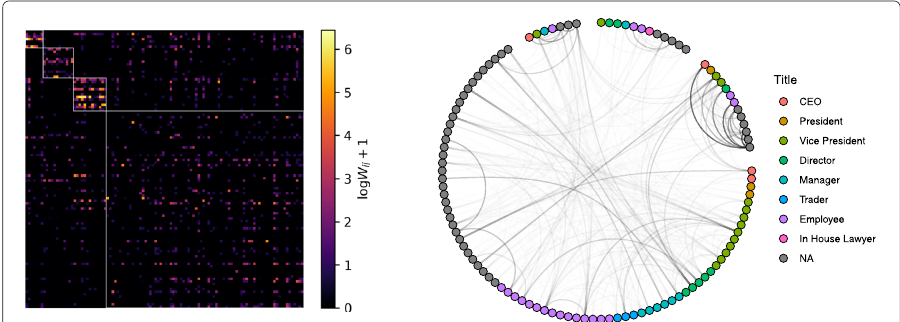
Fig. 4 Example partition of the Enron data set via approximate spectral maximization of Eq. (9). (Left): The adjacency matrix, arranged in order of the partition. Colors give the value of log W ij + 1; log-scaling was chosen for readability. (Right): Visualization of the network. Directed edges have been made undirected. The darkness of each edge corresponds to its weight. The color of each node corresponds to listed job title. In this experiment, k = 4, and the kernel used is the information flow kernel R of Eq. (10). The modularity of the shown partition is